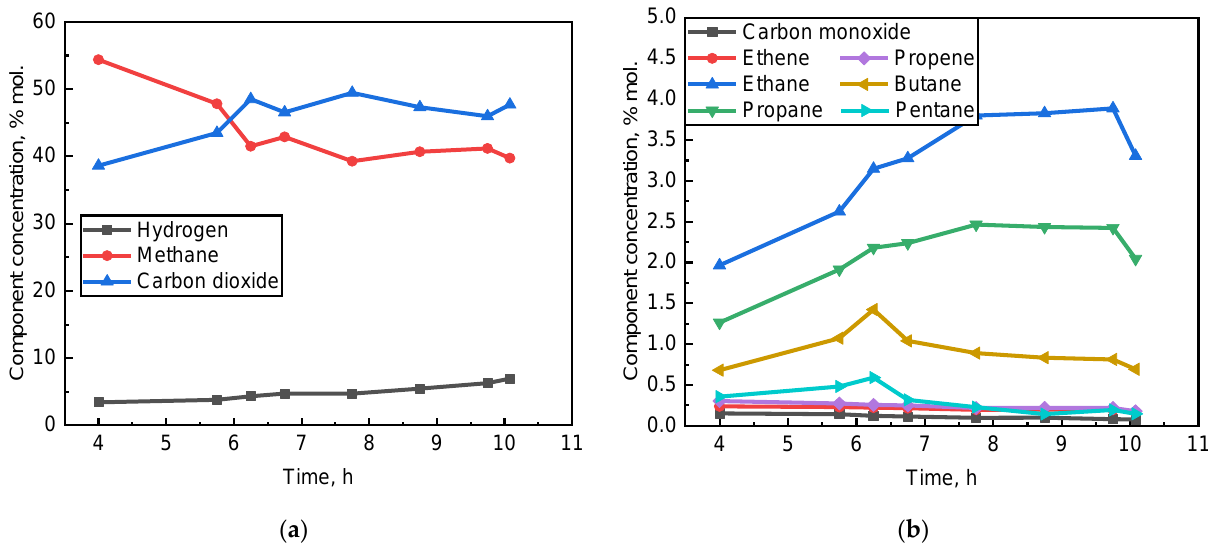
Figure 7. ( a ) The dependencies of major gas component concentrations and ( b ) minor gas component concentrations in product gas mixture in experiment No. 7 on time.